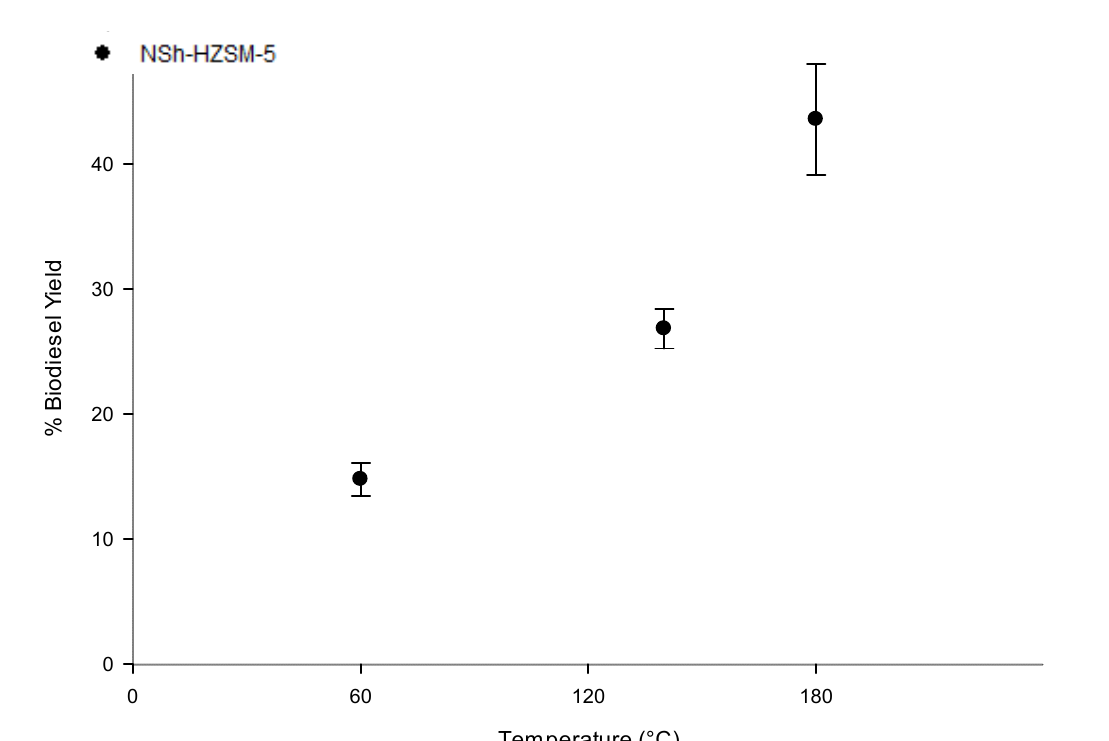
Molecules 2021 , 26 , x FOR PEER REVIEW